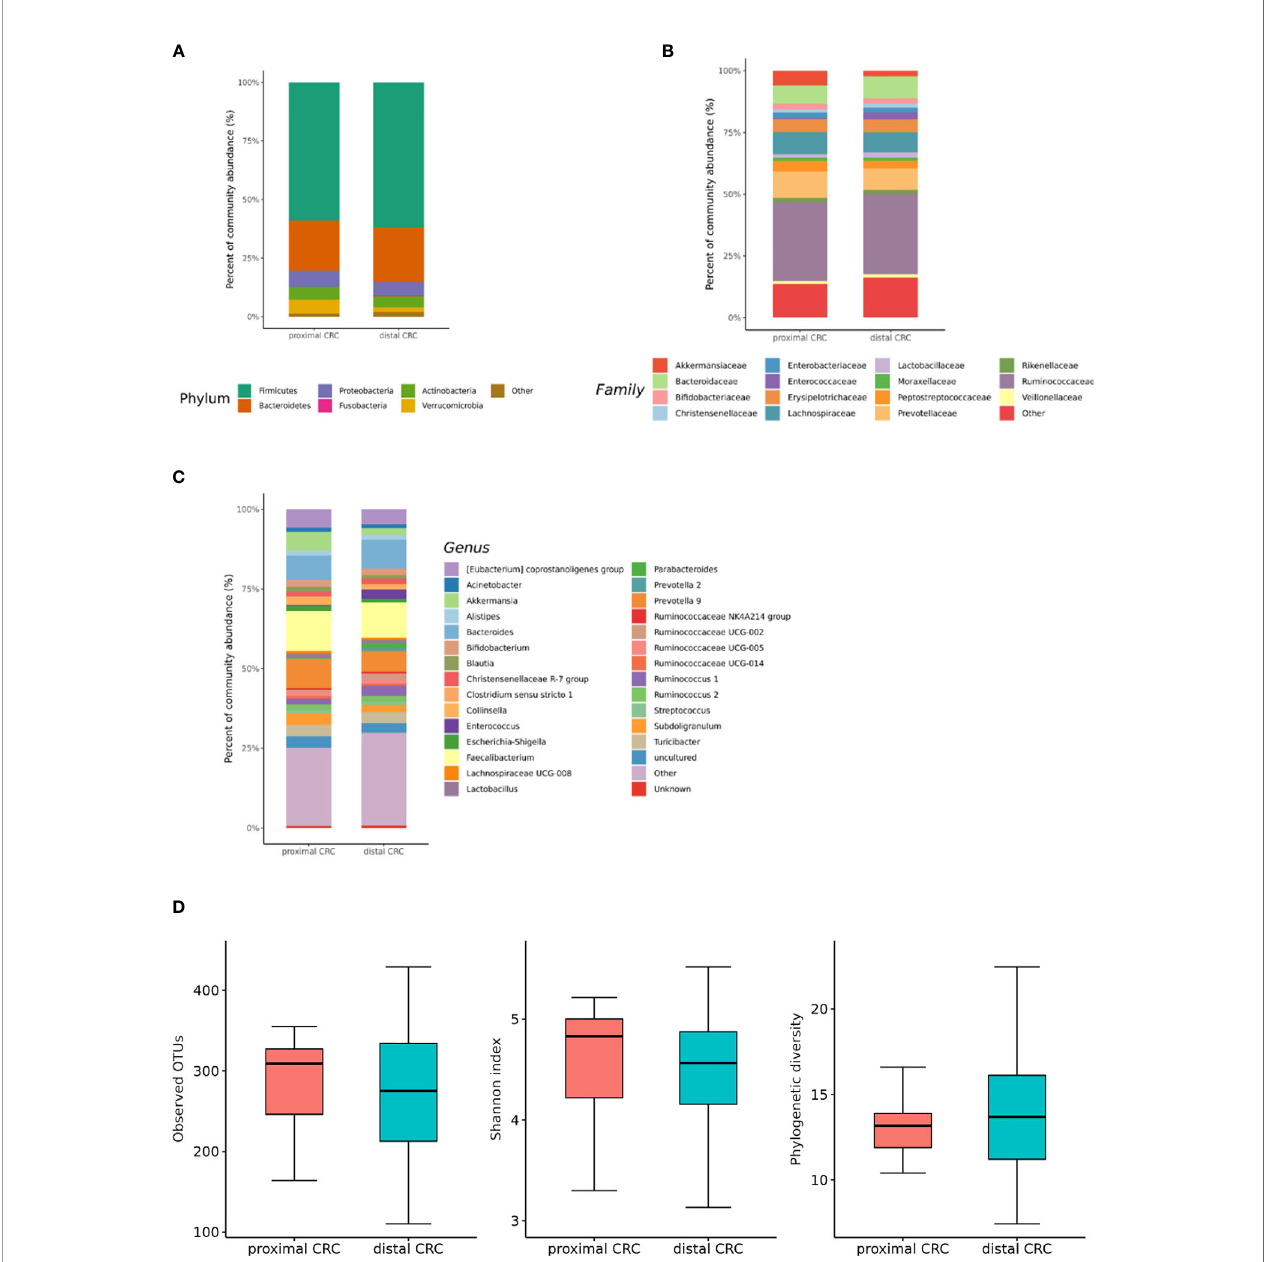
FIGURE 8 | Relative abundance plots of gut microbe-derived extracellular vesicles of proximal CRC (n = 20) versus distal CRC (n = 50) (A) at the phylum, (B) family, and (C) genus levels. (D) Boxplots of alpha diversity indices comparing distal CRC with proximal CRC in gut microbe-derived extracellular vesicles. CRC; colorectal cancer, OTU; operational taxonomic